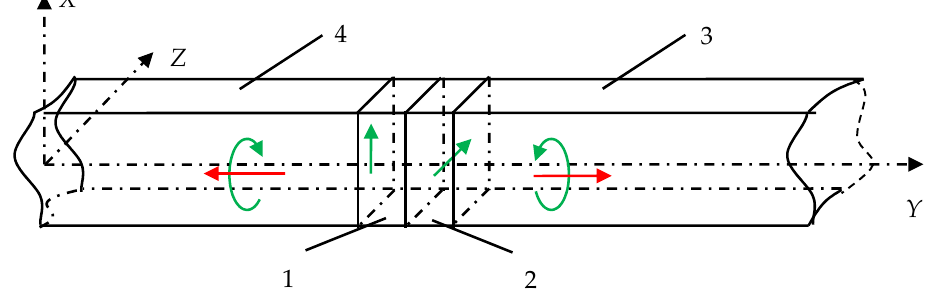
Figure 4. The new design of acoustic transducer for direct radiation of CPAW.